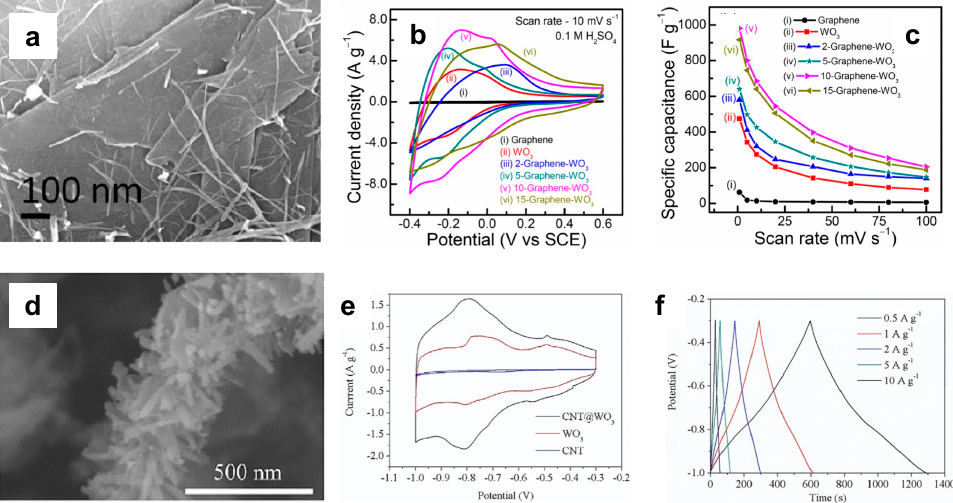
Figure 7. ( a , d ) SEM images, ( b , e ) CV and ( c , f ) Cs as a function of scan rate and GCD curves, of WO 3 – graphene nanocomposites [56], and WO 3 nanorods on CNTs [67]. Reproduced with permission. Table 2. Recent, state-of-the-art progress on energy storage applications of WO 3 –carbon nanocom- posite-based electrodes.